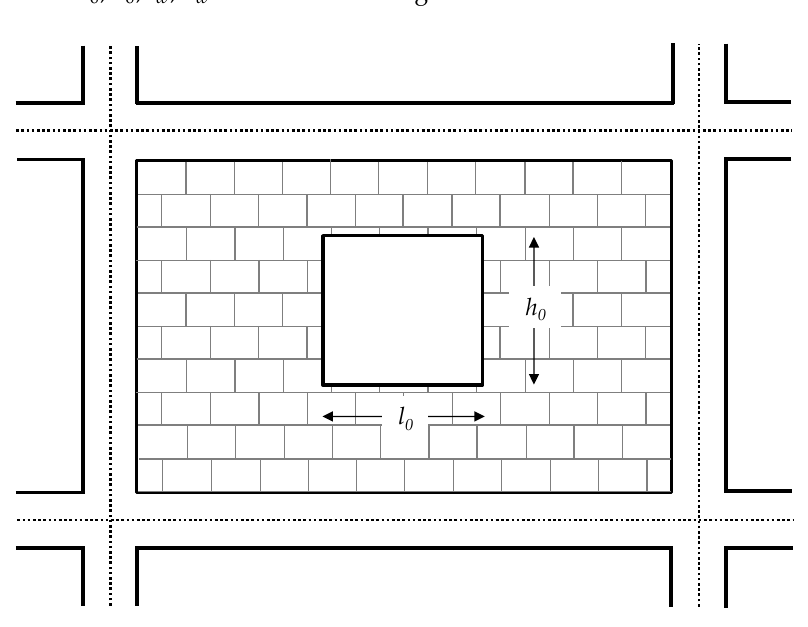
Figure 3. Opening notation adopted in this study.